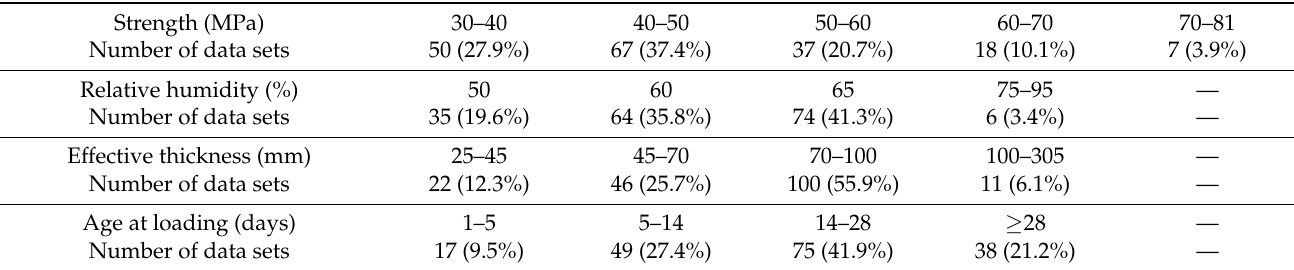
Table 2. Distribution of major parameters of the creep